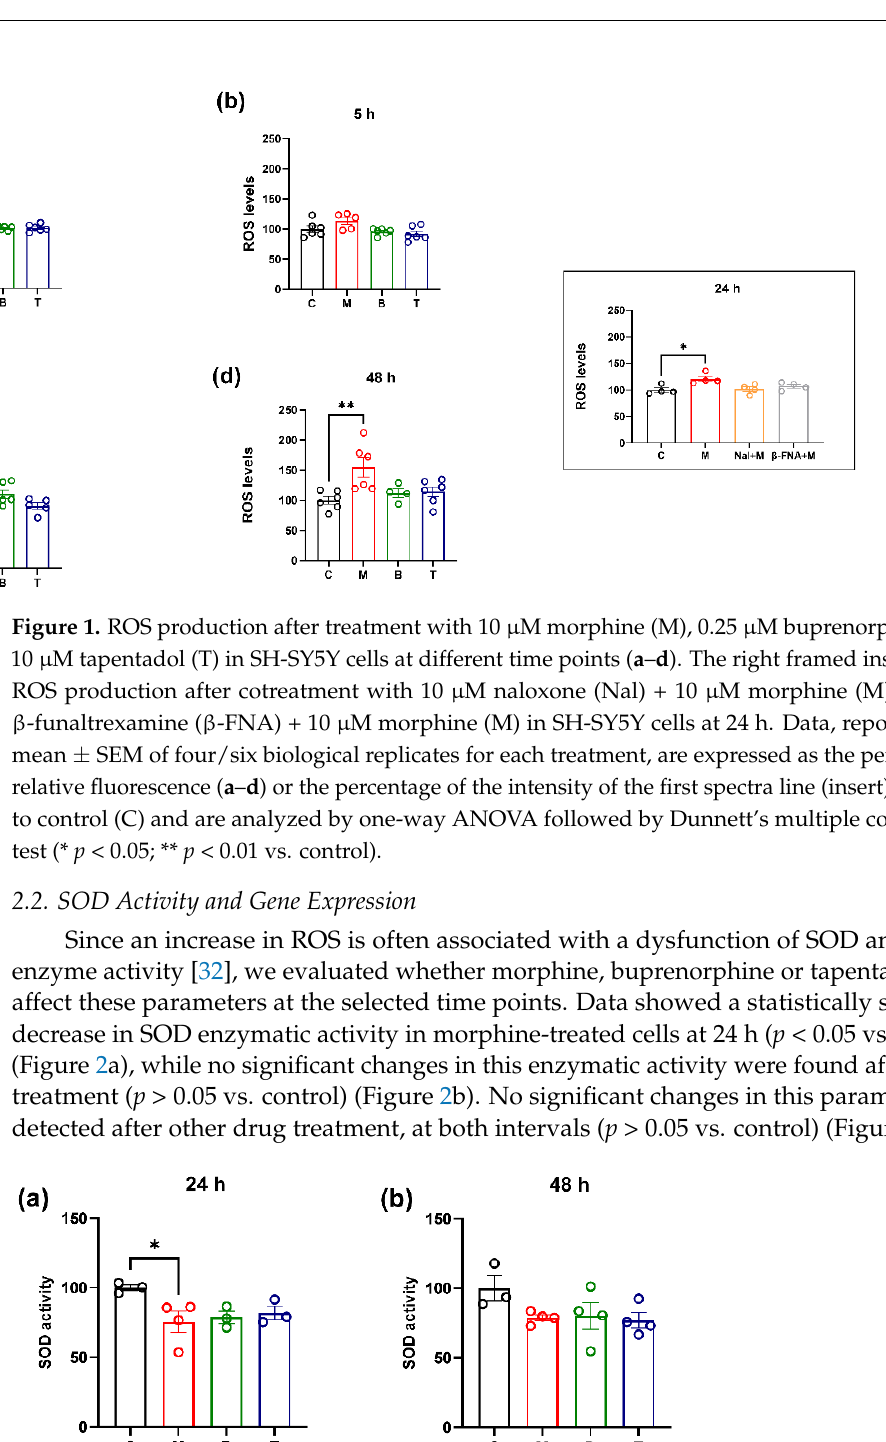
Figure 2. SOD activity after treatment with 10 µM morphine (M), 0.25 µM buprenorphine (B) or 10 µM tapentadol (T) in SH-SY5Y cells at 24 h ( a ) and 48 h ( b ). Data, reported as the mean ± SEM of three/four biological replicates for each treatment, are expressed as the percentage of inhibition rate